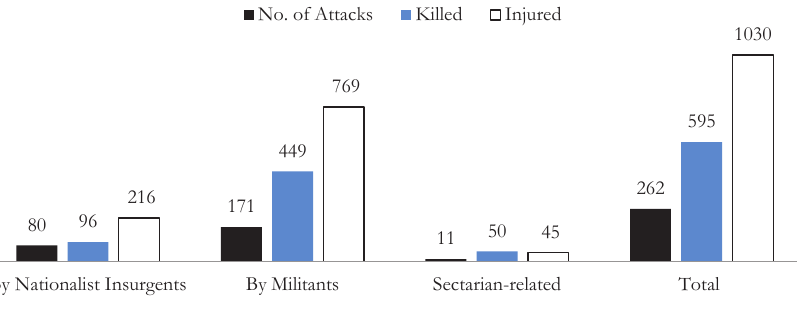
Fig. 3 – Terrorist Attacks in Pakistan for the year 2018. Source: Pakistan Security Report,